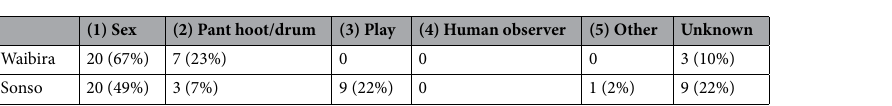
Table 3. Number of observations of leaf-modifying gestures recorded in each context in the Waibira and Sonso chimpanzee communities. Numbers correspond to context descriptions detailed in the methods section and headers are short hands for these